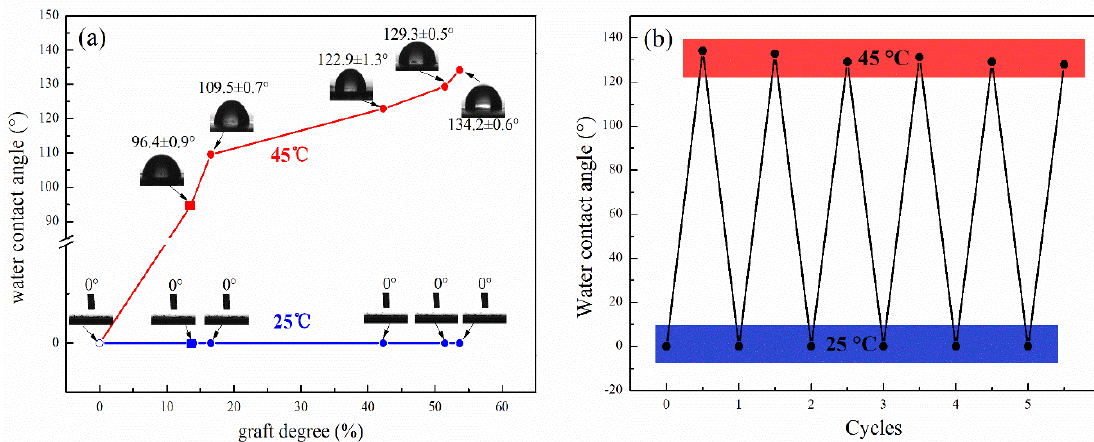
Figure 6. The variation of the Water Contact Angle test of cellulose and cellulose- g -PNIPAAm with different graft degrees at 25 °C and 45 °C, respectively ( a ); Reversible WCA transition of the product at 25 °C and 45 °C, respectively ( b ).